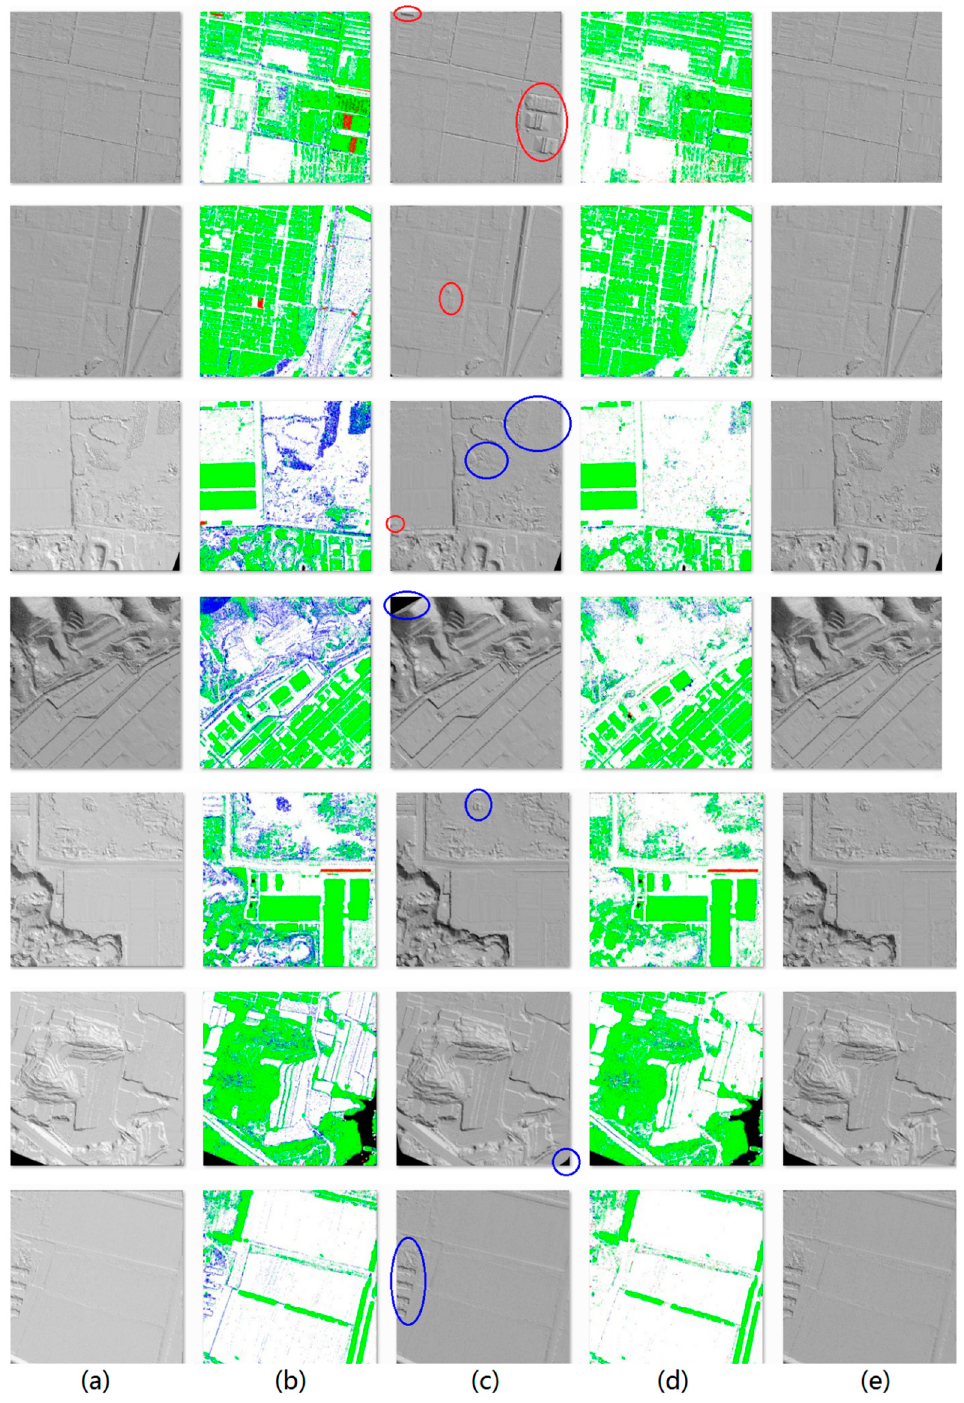
Figure 9. Comparison of the proposed method and TerraScan on the detailed difference of the DTM. Column ( a ) is the ground truth TIN-rendered gray image of the test data. Columns (b,d) are the results of filtration by TerraScan and Deep CNN, respectively; the white points denote correctly classified ground points, the green points denote correctly classified non-ground points, the red points denote accepted non-ground points, and the blue points denote rejected ground points. Columns ( c ) and ( e ) are TIN-rendered DTM extracted from the results of filtration by TerraScan and deep CNN model, respectively. In Column ( c ), blue ellipses denote type I error and red ellipses denote type II error.